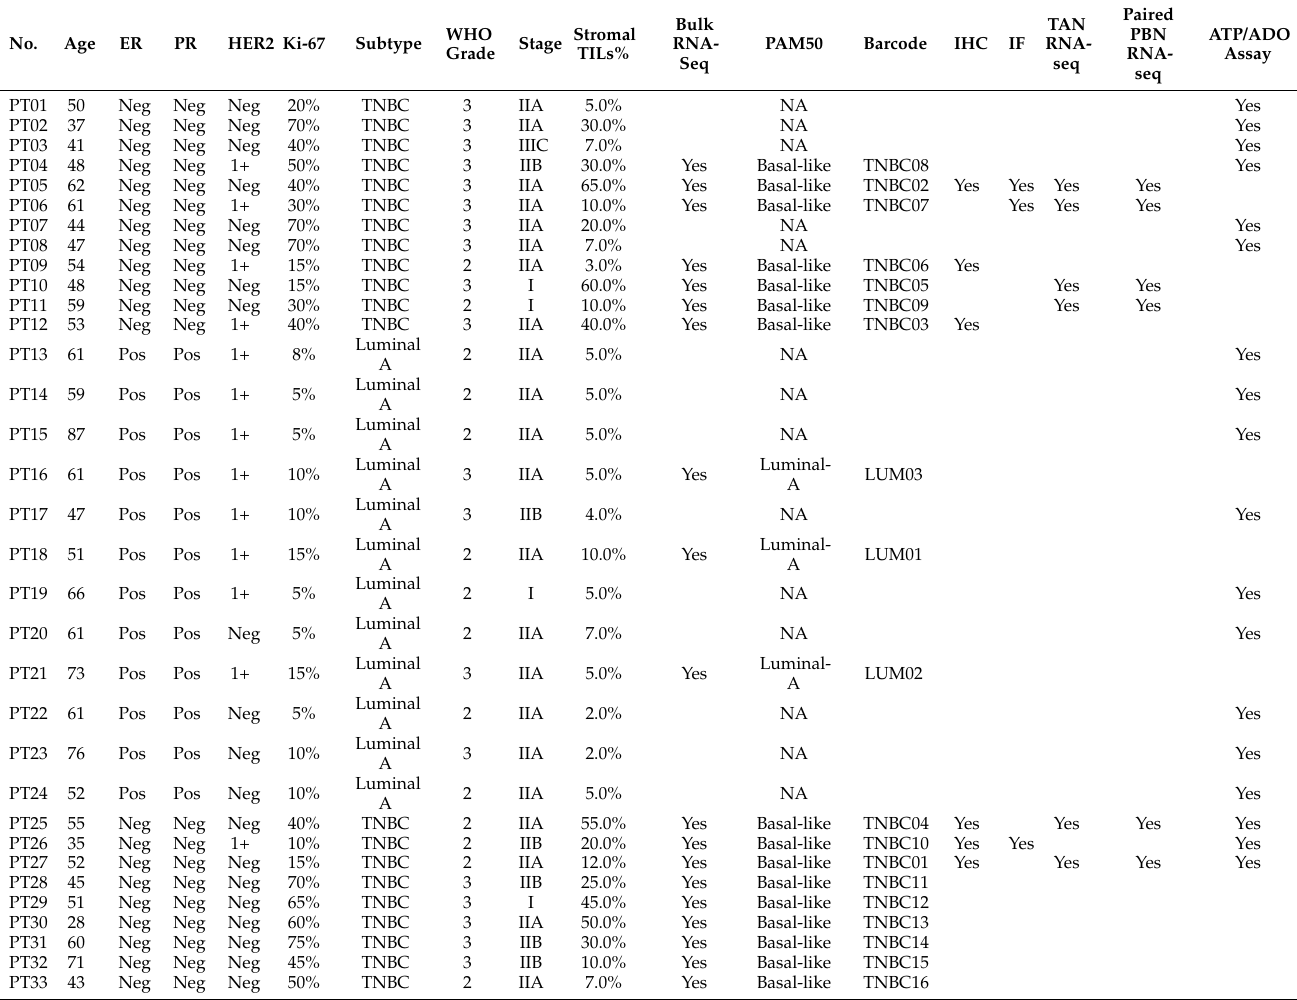
Table 1. Clinical baseline characteristics of the included patients and corresponding experimental procedures for the